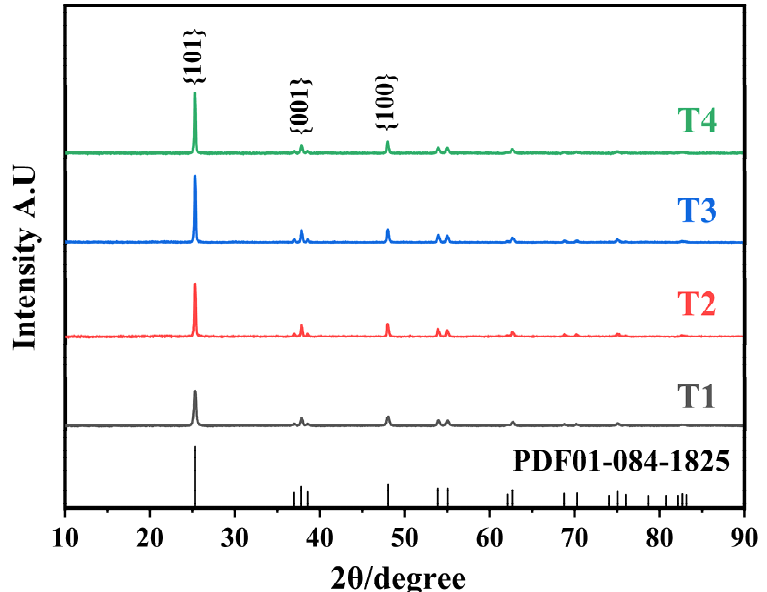
Figure 1. XRD patterns of samples treated with different NaF concentrations, denoted as T1, T2, T3 and T4,